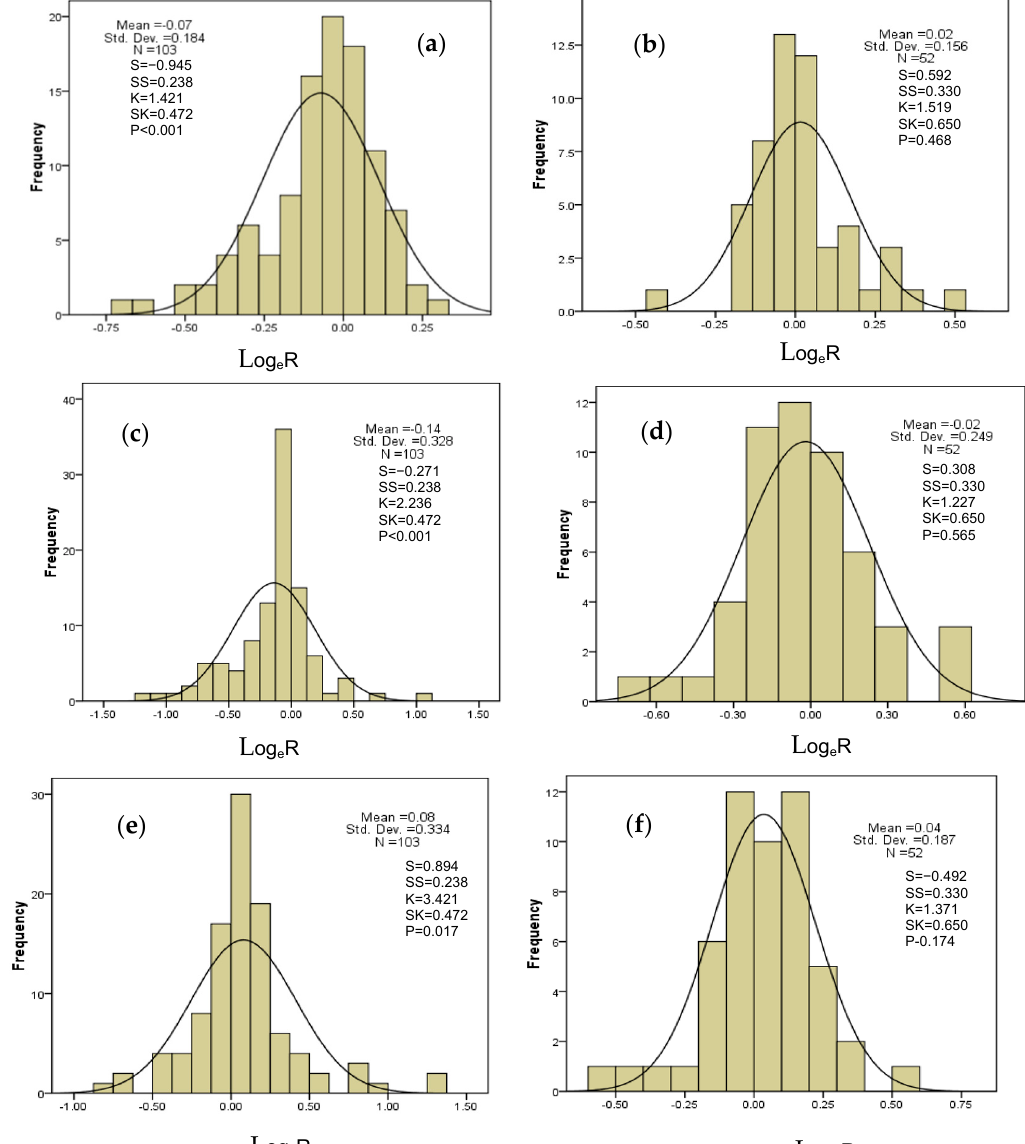
Figure 5. The frequency distribution of the effect size (natural log of the response ratio, Log e R) for arbuscular mycorrhizal plant N ( a ), ectomycorrhizal plant N ( b ), arbuscular mycorrhizal plant P ( c ), ectomycorrhizal plant P ( d ), arbuscular my- corrhizal plant N:P ratio ( e ), and ectomycorrhizal plant N:P ratio ( f ) to drought stress. Additionally, the mean effect size of drought stress on dendritic mycorrhizal plant N, P, and N:P ratio and ectomycorrhizal plant N, P, and N:P ratio. The solid curve in ( a – f ) is a Gaussian distribution matching the frequency data (n, number of observations). The error bars in ( f ) represent 95% bootstrapped confidence intervals (CIs). The effect of drought stress was considered significant if the 95% CI of loge R did not overlap with zero. In the figure, S refers to skewness, SS refers to the standard error of skewness, K refers to kurtosis, and SK refers to the standard error of kurtosis. If the |S − 0| / SS < 1.96, |K − 0|/SK < 1.96, the data follows normal distribution. 2.7. Different Effects of Pot or Field Treatment on AM and ECM Plant N, P, and N:P Ratio We used two planting conditions altogether—pot and field. Drought has a great in- fluence on N concentration in both field and pot cultivations conditions, but the effect of drought on N in field experiment is greater than that of pot cultivation experiment ( − 0.1269%, Figure 6a). The absorption of P by AM plants decreased in both field and pot experiments (by 0.1451% and 0.1317%, respectively, Figure 6b). In field experiment, the absorption of the N:P ratio was not significantly affected, but the absorption of the N:P ratio, in pot experiment, was positively affected (+0.0994%, Figure 6c). For ECM plants, field experiment had a negative effect on N absorption, but the effect was smaller than that of AM plants. The N absorption of ECM plants had a positive effect in Pot experiment, and more than AM plants, but P does not change (Figure 6a). There was no significant difference in the effect of ECM plants on P in field and pot experiments (Figure 6b). The N:P ratio of ECM plants was improved in pot experiment (+0.1092%, Figure 6c), which was significantly higher than that under field conditions (a decrease of 0.0538, Figure 6c). In addition, the effect of ECM plant N:P ratio was greater than that of AM plants in both field and pot conditions.